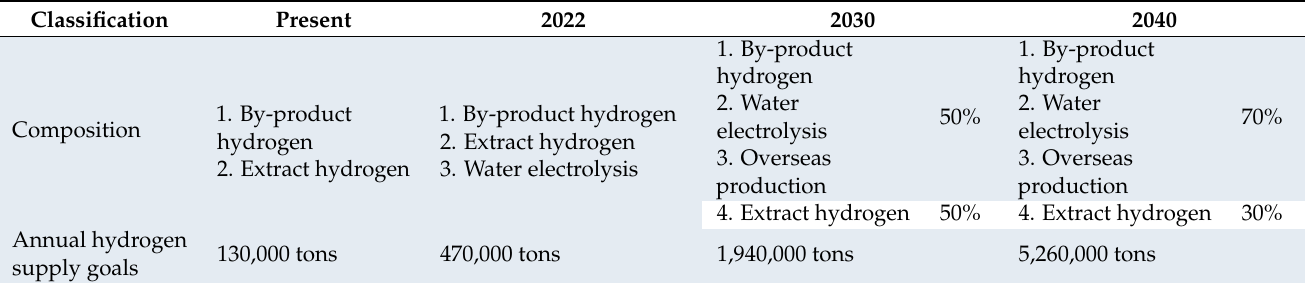
Table 2. Goals for hydrogen production composition, and